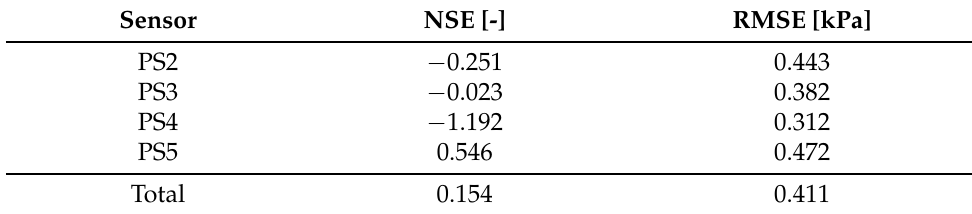
Table 7. Performance indicators of the peak pressure P .